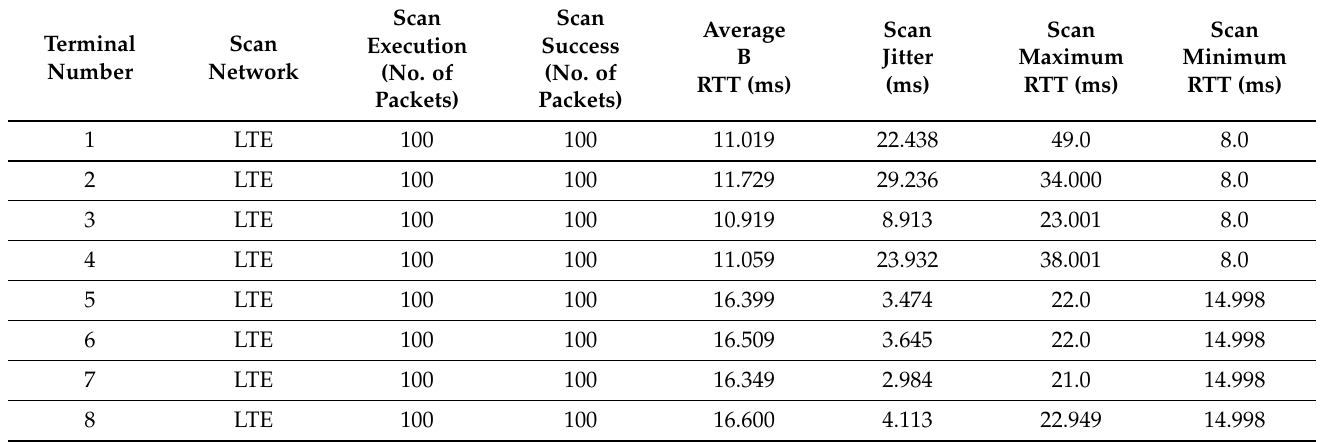
Table 1. Example of scan response in a normal network